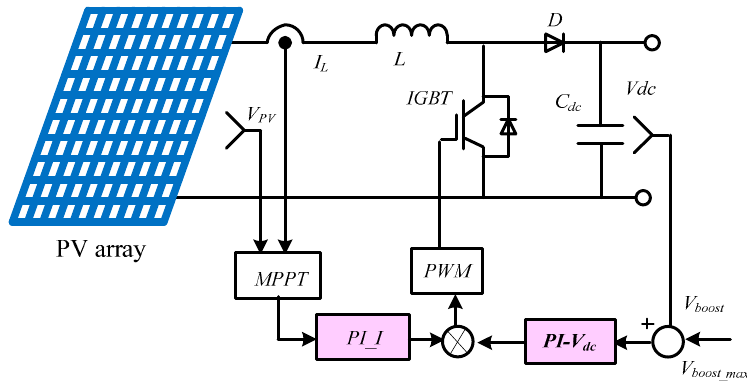
Figure 3. Maximum power point tracker (MPPT)control of boost DC-DC converter .